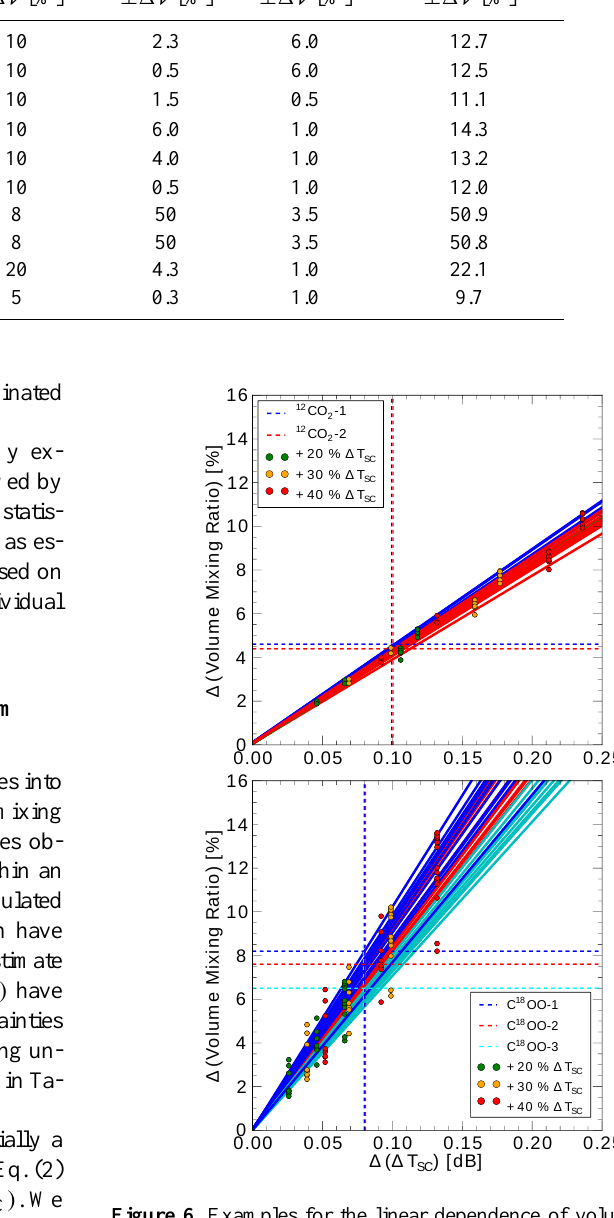
Figure 6. Examples for the linear dependence of volume mixing ratio uncertainty (cid:49)( V ) (%) on spectral correction term uncertainty (cid:49)((cid:49) T SC ) (dB), for the 12 CO 2 -1 | 2 peaks (upper panel; blue and red) and the C 18 OO-1 | 2 | 3 peaks (lower panel; blue, red, cyan). The linear transfer functions (bundles of colored solid lines per species peak) and the cross-check results for the (cid:49)( V ) [ (cid:49)((cid:49) T SC ) ] relation from actual retrieval (color-filled circles) are explained and dis- cussed in Sect.